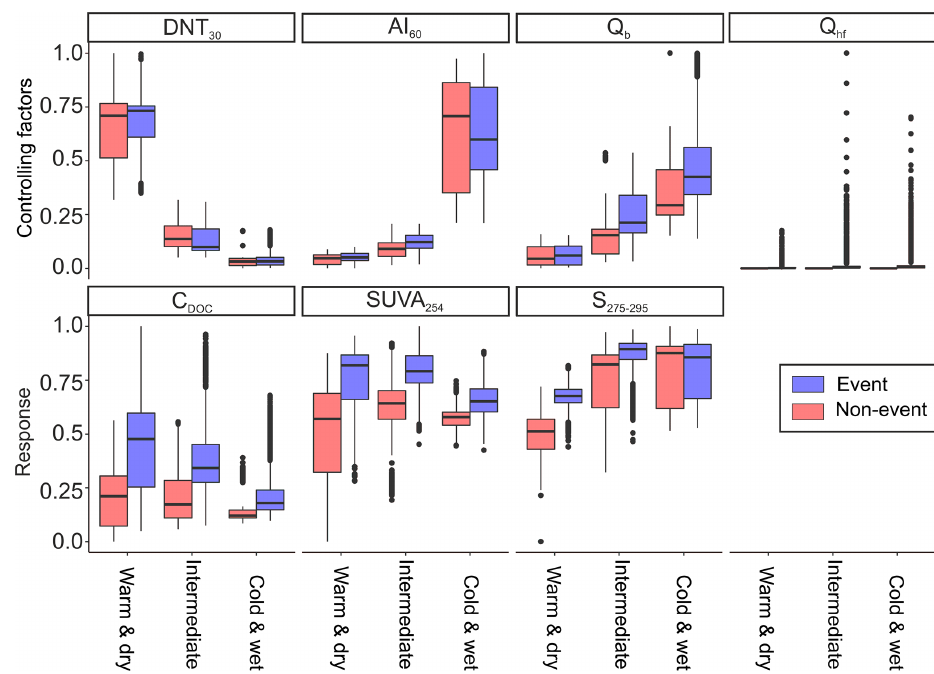
Figure 5. Box plots of hydroclimatic variables (controlling factors) and DOC quantity and quality metrics (response) classified into three hydroclimatic states: (1) warm and dry, (2) intermediate, (3) cold and wet. Red indicates non-event situations, and purple indicates event situations during the according states. Variables were rescaled for better illustration. Particular median C DOC values during non-event situ- ations were 4.13, 3.72 and 3.16mgL − 1 for the warm and dry, intermediate, and cold and wet states, respectively. Both warm and dry and intermediate states differ highly significantly (Kruskal–Wallis test, p< 0 . 001) from the cold and wet